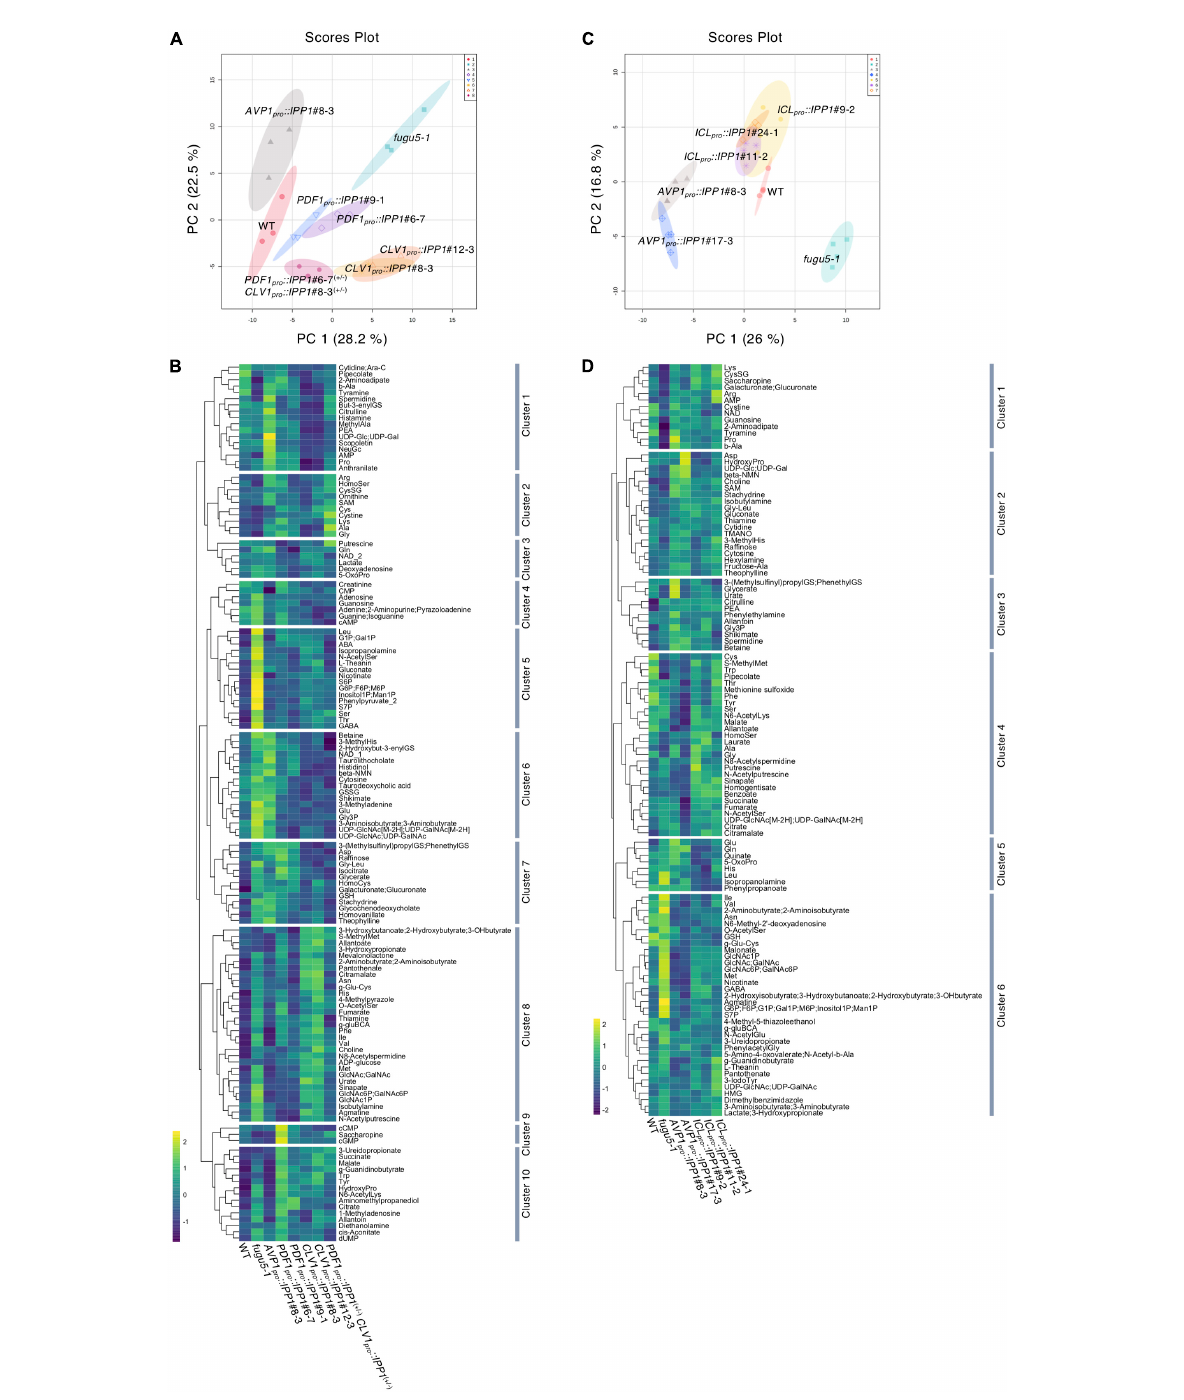
FIGURE6 Effect of spatiotemporal expression of IPP1 on the fugu5 background on the metabolic profiles of etiolated seedlings determined by capillary electrophoresis time-of-flight mass spectrometry (CE-TOF MS). The MetaboAnalyst (v.5.0) website was used to normalize the data and perform principal component analysis (PCA). The normalization procedures consisted of mean-centering and division by the standard deviation of each variable. (A) The PCA plot based on three independent experiments involving the wildtype (WT), fugu5-1 , AVP1 pro ::IPP1 #8-3, PDF1 pro ::IPP1 #6-7, PDF1 pro ::IPP1 #9-1, CLV1 pro ::IPP1 #8-3, CLV1 pro ::IPP1 #12-3, and PDF1 pro ::IPP1 #6-7 ( + / − ) CLV1 pro ::IPP1 #8-3 ( + / − ) lines. (B) Hierarchical clustering heat map of the relative abundances of metabolites. Scale indicates the color code relative to normalized metabolite abundance. (C) PCA score plot from four independent experiments involving the WT, fugu5-1 , AVP1 pro ::IPP1 #8-3, AVP1 pro ::IPP1 #17-3, ICL pro ::IPP1 #9-2, ICL pro ::IPP1 #11-2, and ICL pro ::IPP1 #24-1 lines. (D) Hierarchical clustering heat map of the relative abundances of metabolites. Scale indicates the color code relative to normalized metabolite